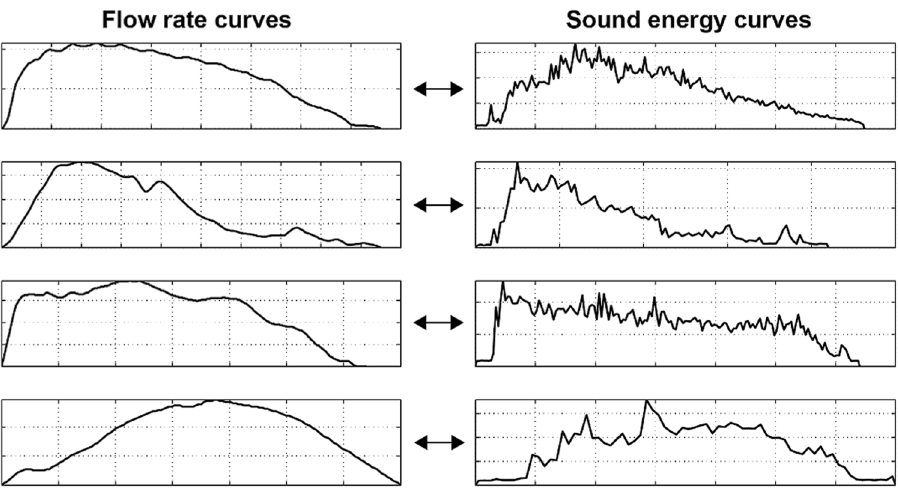
Figure 1. Flow rate and corresponding sound energy curves. The left-hand side graph shows the flow rate across time, and the right-hand side shows the corresponding sound energy across time. The y-scales in the graphs have different units and were scaled to visually highlight the similarity between the shapes of the